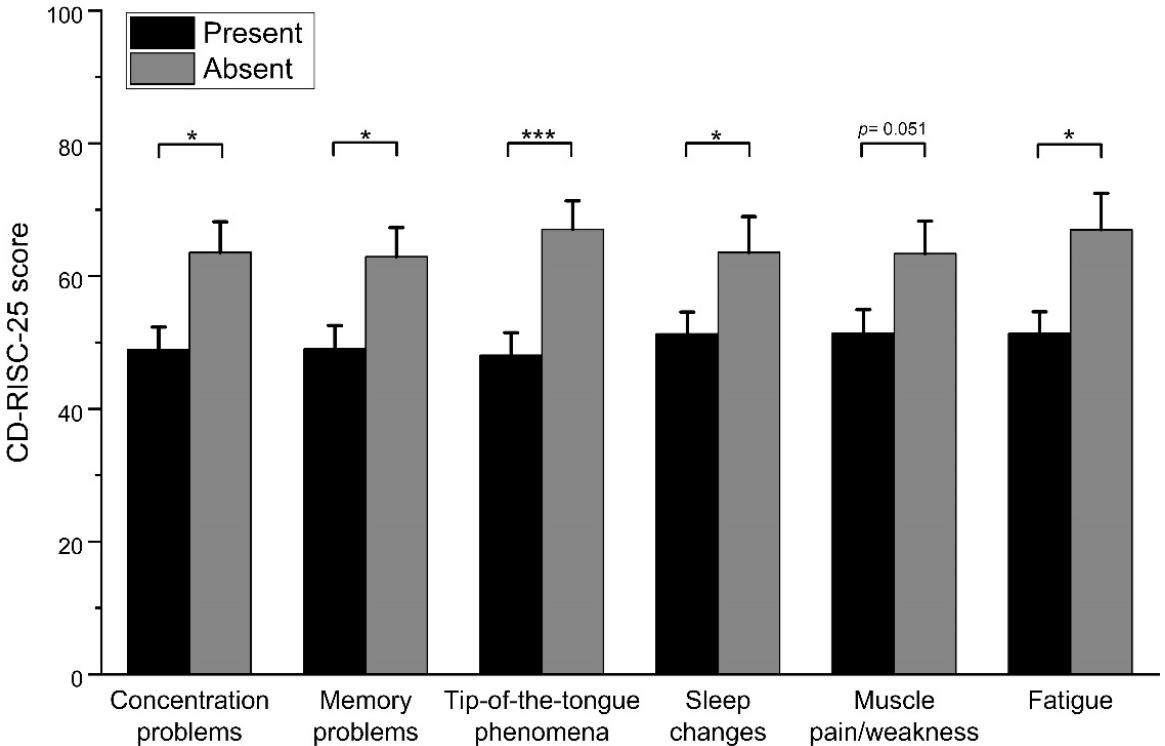
Figure 2. Differences in CD-RISC-25 score based on presence vs. absence of specific persisting symptoms. CD-RISC-25 = Connor-Davidson Resilience Scale 25-items version. Asterisks denote statistically significant differences (* = p < 0.05, *** = p < 0.001).